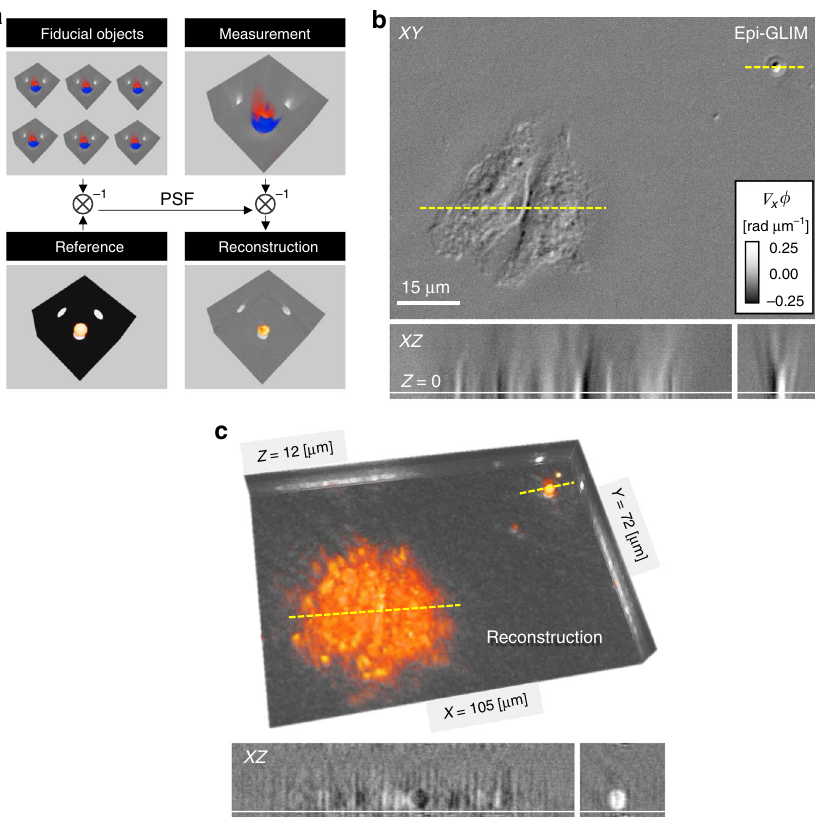
Fig. 4 Control object used to reconstruct an unknown sample. a The system ’ s impulse response is measured from a series of known microspheres. When the known shape of the structure is deconvolved from the measured data, the difference contains the system point spread function (PSF). We combined the PSF measurement with the reconstruction step to avoid using two regularizers and recovered the reconstructed volume from subsequent measurements (see Eq. (4)). b Epi-GLIM image of a HeLa cell and 3 μ m beads before the tomographic reconstruction (×40/0.75). c Same fi eld of view after the 3D reconstruction showing the cell and bead with the expected spherical morphology. XZ slices are cut along the yellow dash